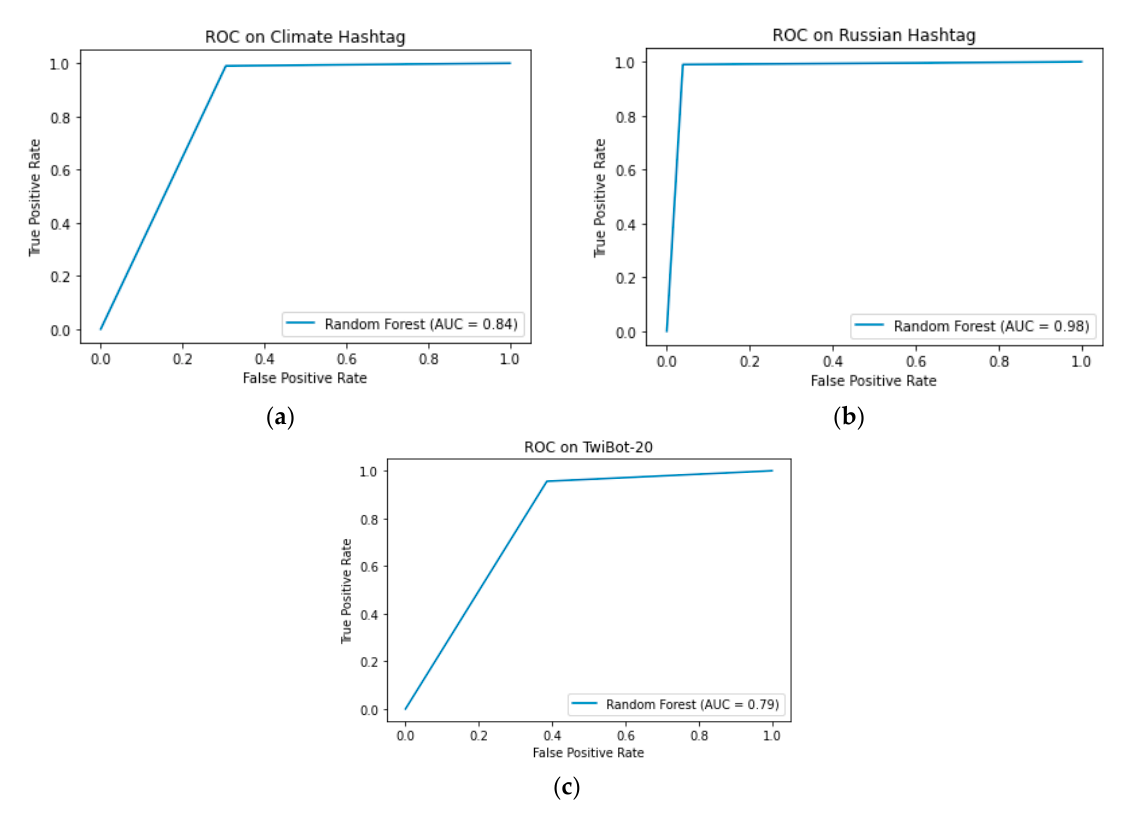
Figure 6. ( a ) The climate hashtag area under the curve (AUC) using Bot-MGAT TL was 0.84. ( b ) The Russian hashtag area under the curve (AUC) using Bot-MGAT TL was 0.98; this highlighted the number of bots that were in the Russian hashtag compared to the climate change hashtag. ( c ) The Twibot20 area under the curve (AUC) was 0.79.